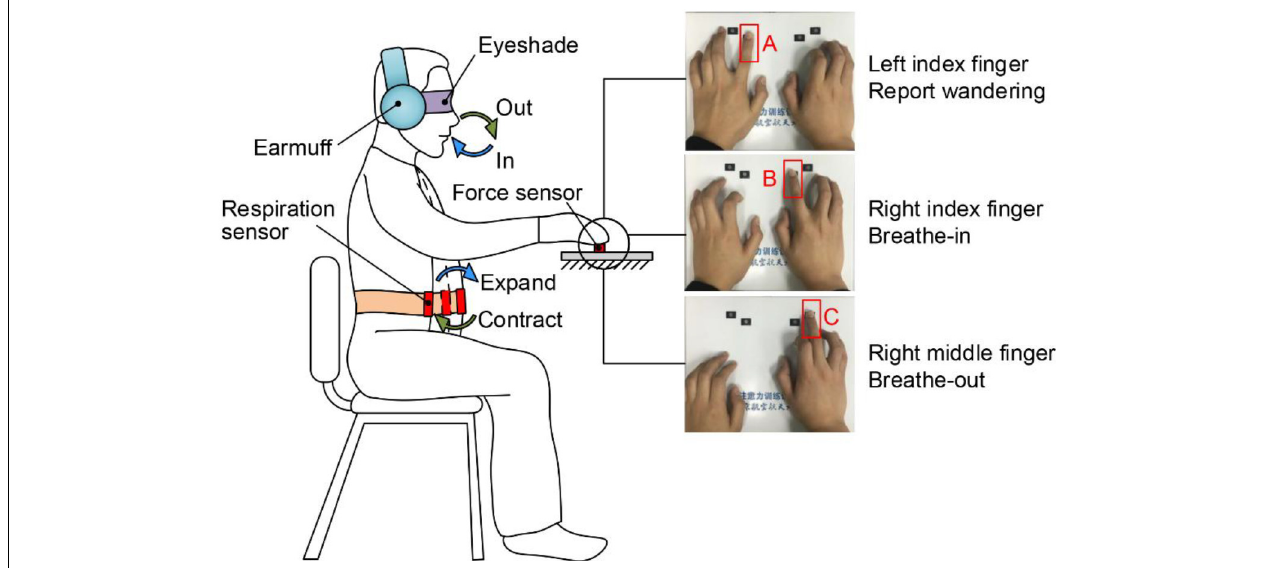
FIGURE 1 | Experimental task. Participants sat in a chair in front of the fixed force-sensor plate, tied a respiration sensor belt to the abdomen, and wore an eyeshade and a pair of earmuffs. They clicked button B using the right index fingertip when beginning to breathe in and clicked button C using the right middle fingertip when beginning to breathe out. Button A was clicked by the left index fingertip to report mind wandering whenever the participants were aware of it. The data of fingertip force pulses and respiration were recorded in real-time.